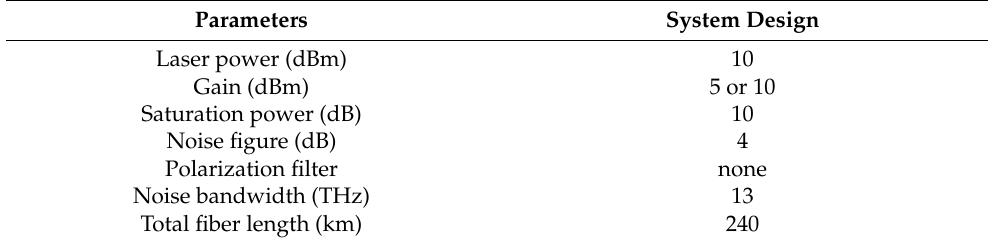
Table 8. Parameters of the designed model EDFA.